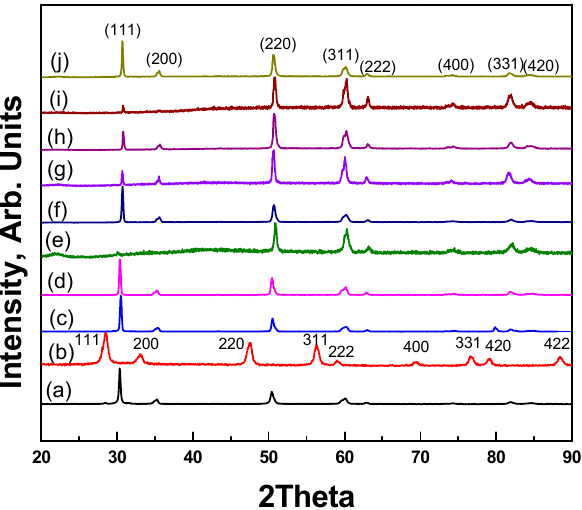
Figure 3. X-ray diffraction (XRD) patterns of the ( a ) 8YSZ Powder; ( b ) CeO 2 powder; ( c ) conventional sintering (CS) 8YSZ; ( d ) Microwave sintering (MW) 8YSZ; ( e ) CS 8YSZ + 10 wt % CeO 2 ; ( f ) MW 8YSZ + 10 wt % CeO 2 ; ( g ) CS 8YSZ + 12 wt % CeO 2 ; ( h ) MW 8YSZ + 12 wt % CeO 2 ; ( i ) CS 8YSZ + 15 wt % CeO 2 ; ( j ) MW 8YSZ + 15 wt % CeO 2 .